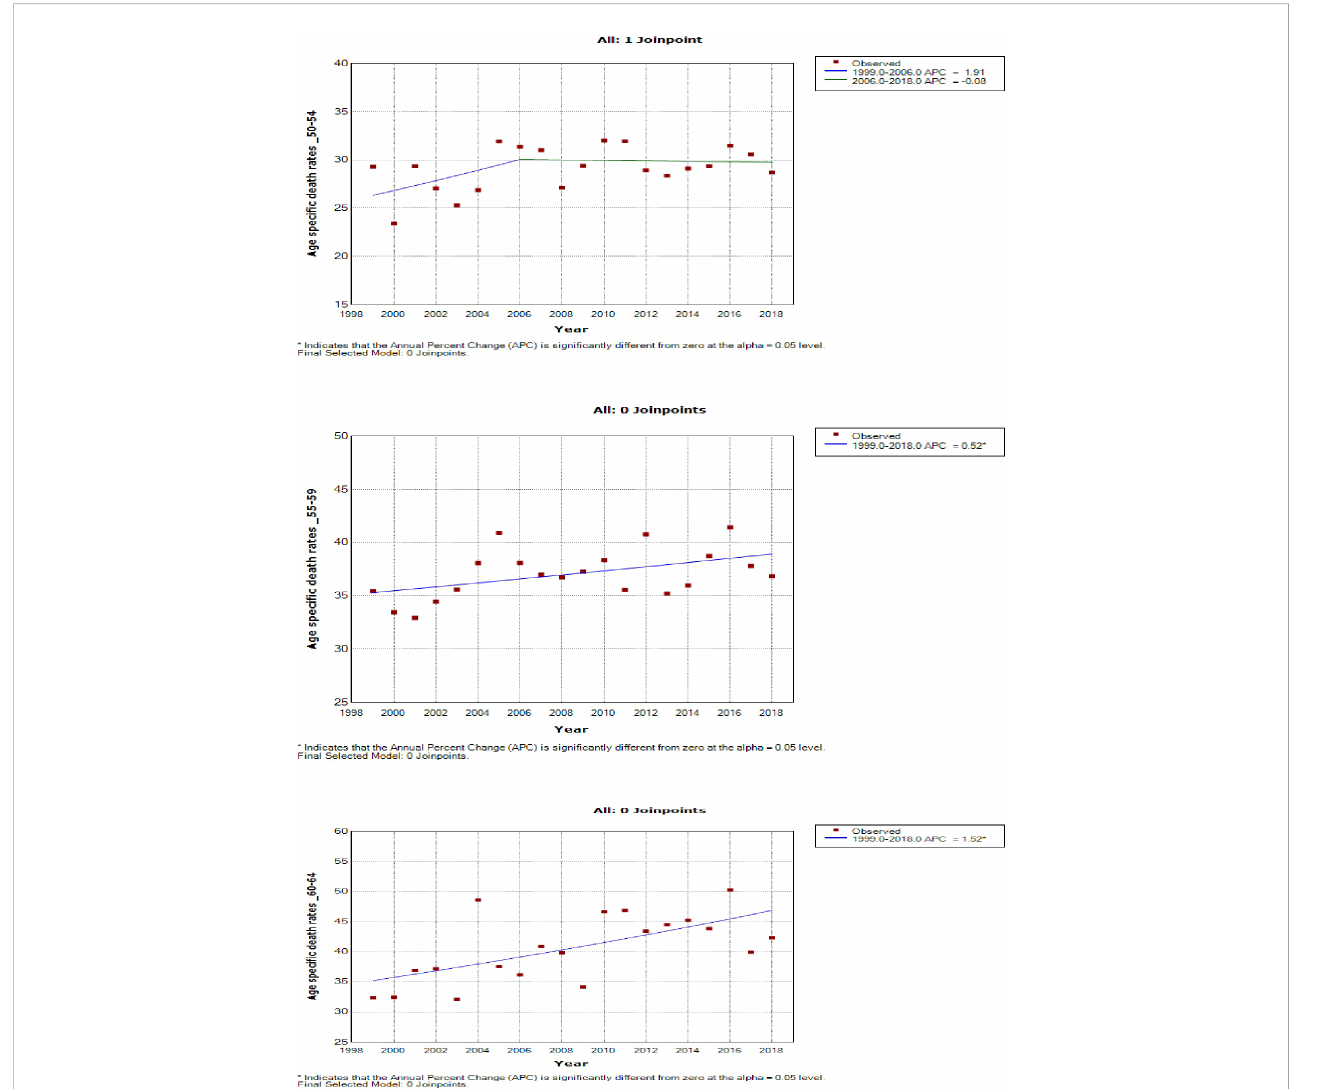
FIGURE 8 Joinpoint trends of age-speci fi c death rates of breast cancer in South Africa, 1999 – 2018, among 50 – 64-year-olds (5-year